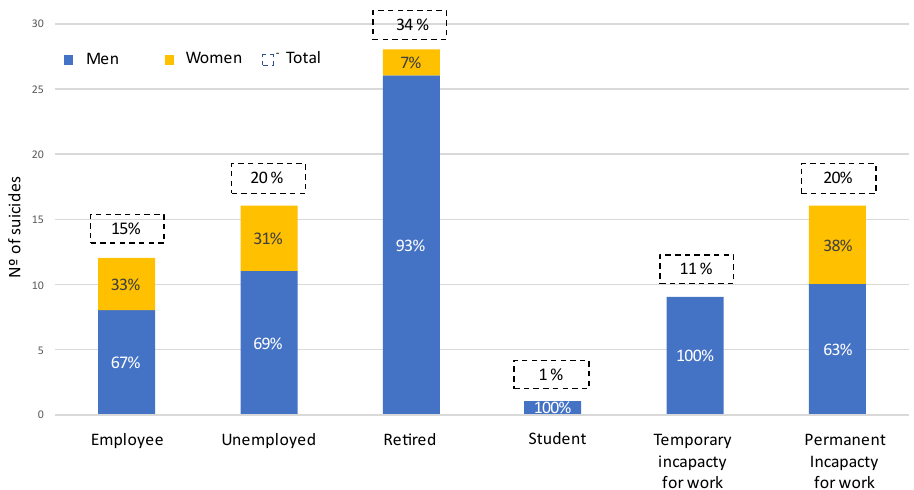
Figure 3. Graphical representation of the employment situation of the study